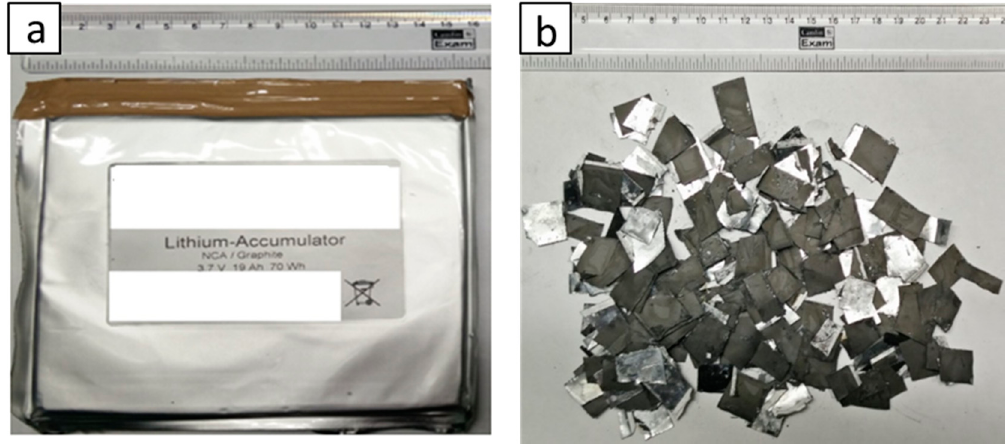
Figure 1. ( a ) The battery used for the experiment and ( b ) starting material for the experiment.